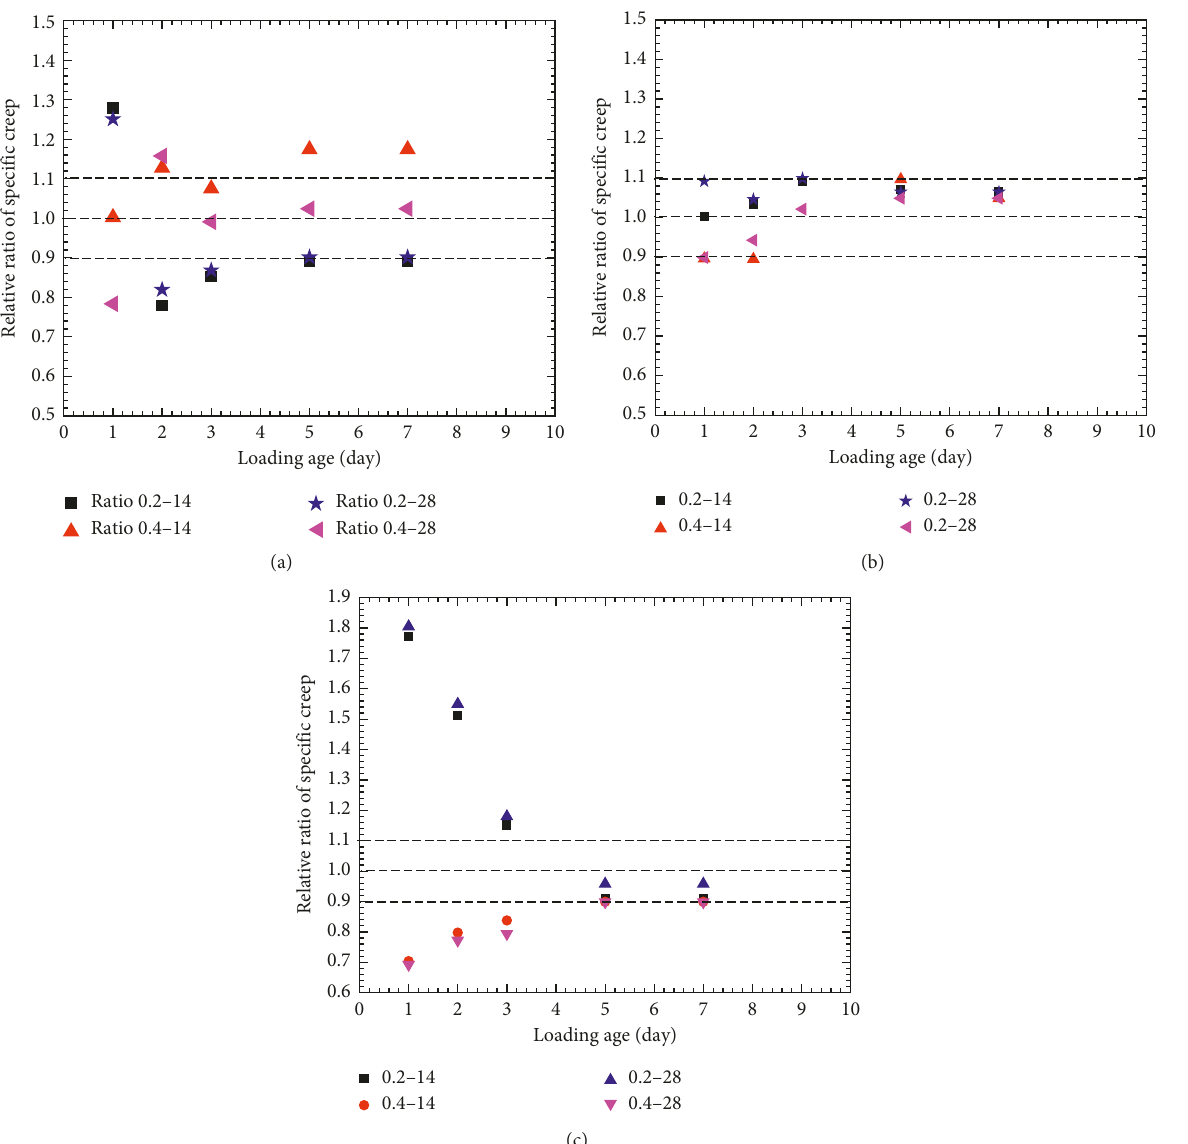
Figure 8: Relative specific creep (tensile creep under the stress/strength ratio of 0.2 or 0.4/tensile creep under the stress/strength ratio of 0.3): (a) FA, (b) BS, and (c) trinary